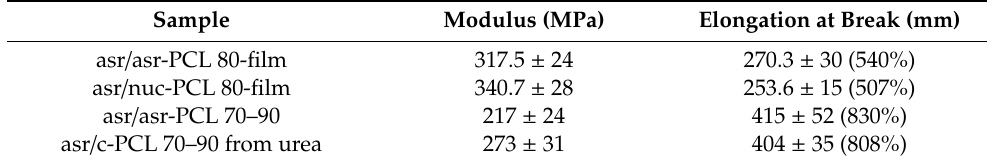
Table 2. Tensile test results for bilayer films obtained with permission from [43]. Copyright 2015 American Chemical Society.